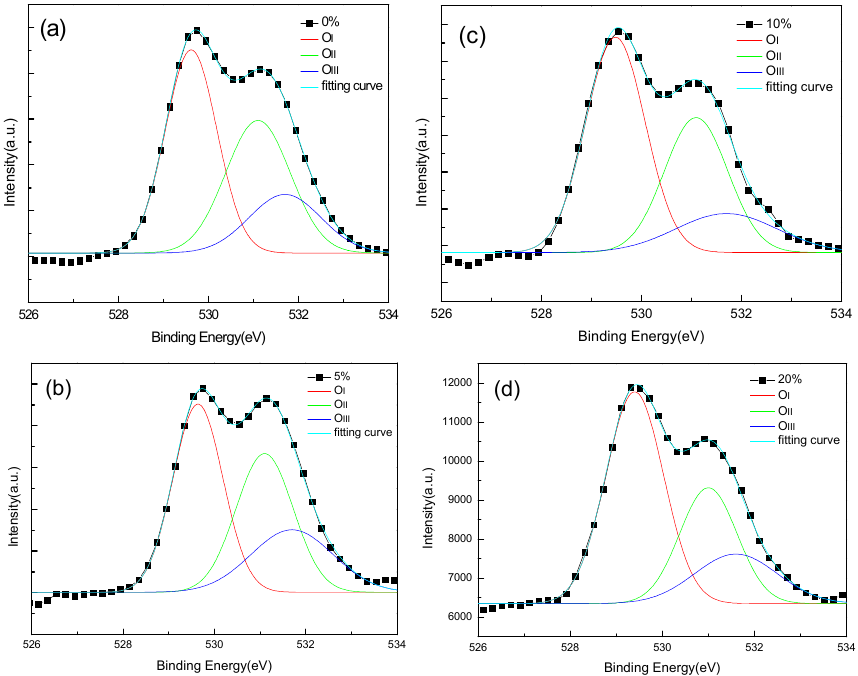
Figure 5. X-ray photoelectron spectroscopy (XPS) spectra of O 1s of IGO film with ( a ) 0%; ( b ) 5%; ( c ) 10%; and ( d ) 20%.